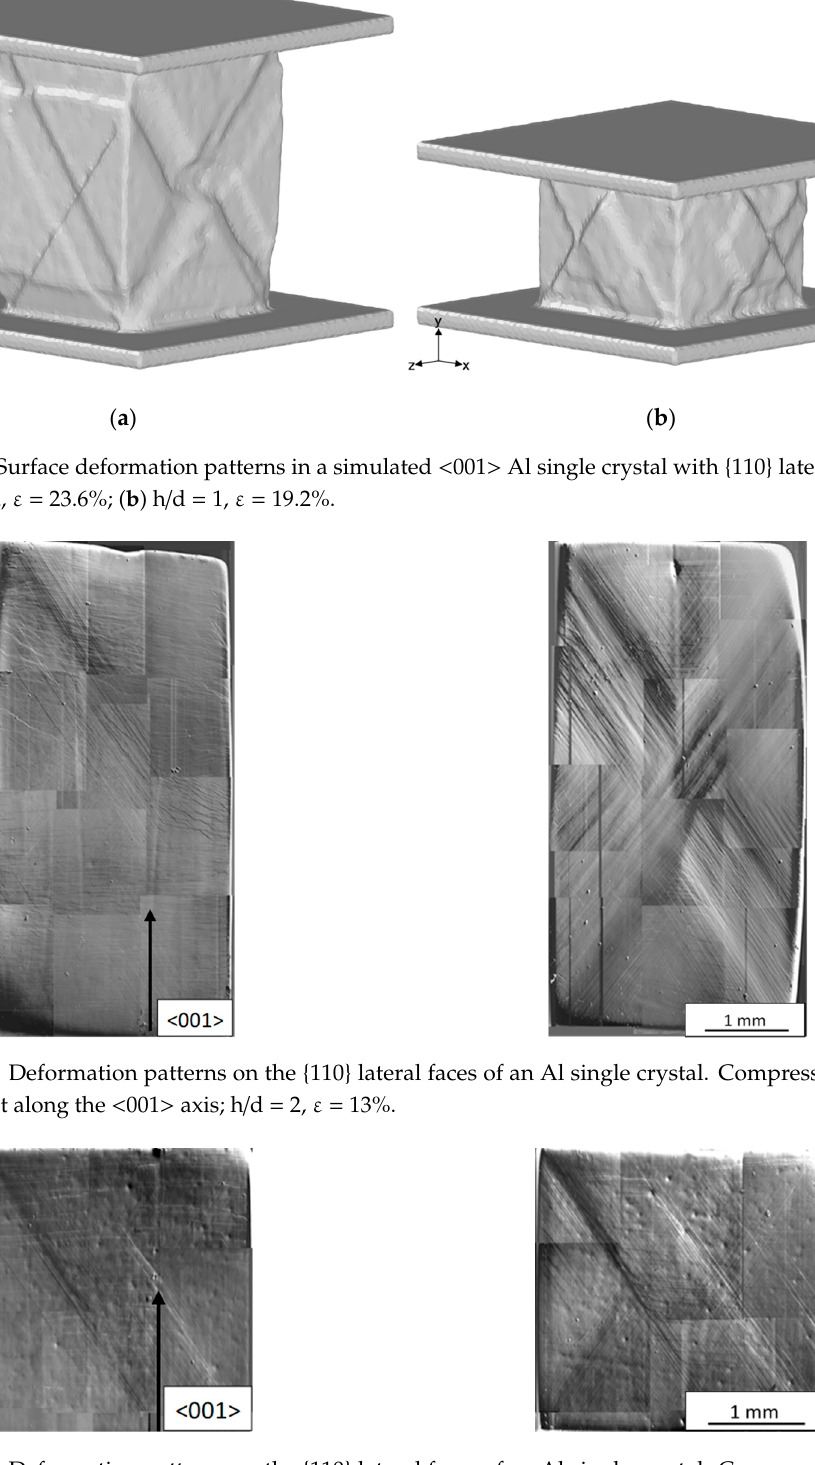
Figure 11. Deformation patterns on the {110} lateral faces of an Al single crystal. Compression was carried out along the <001> axis; h/d = 1, ε = 6%.